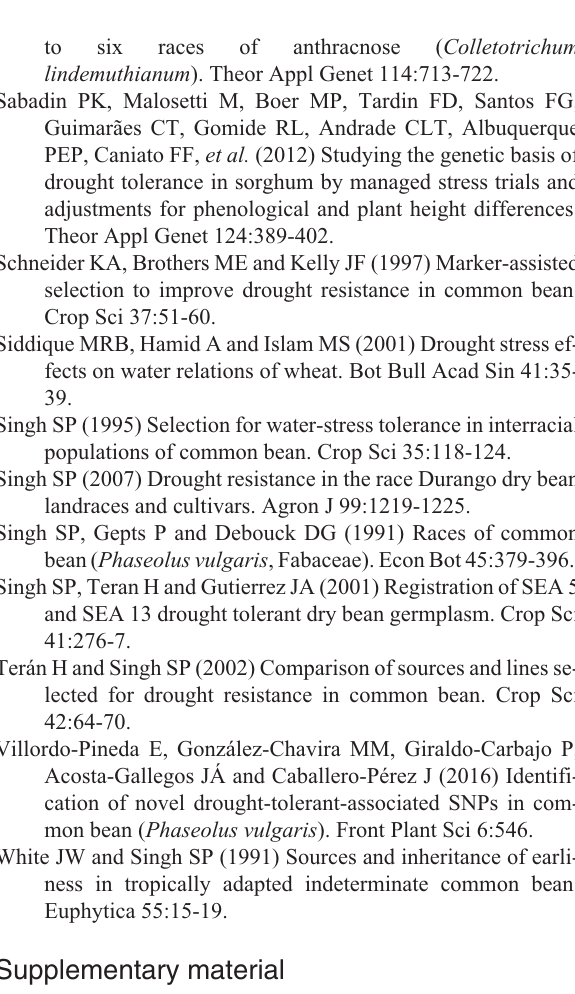
Figure S1 - Distribution of quantitative traits across the RILs. Table S1 - Descriptive statistics for the quantitative traits evaluated in the AND 277 x SEA 5